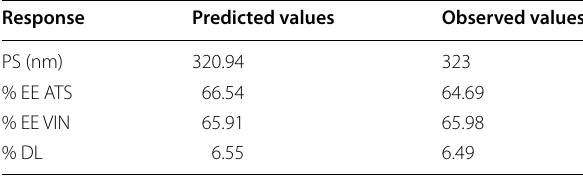
Table 6 Observed versus Predicted values of optimized batch